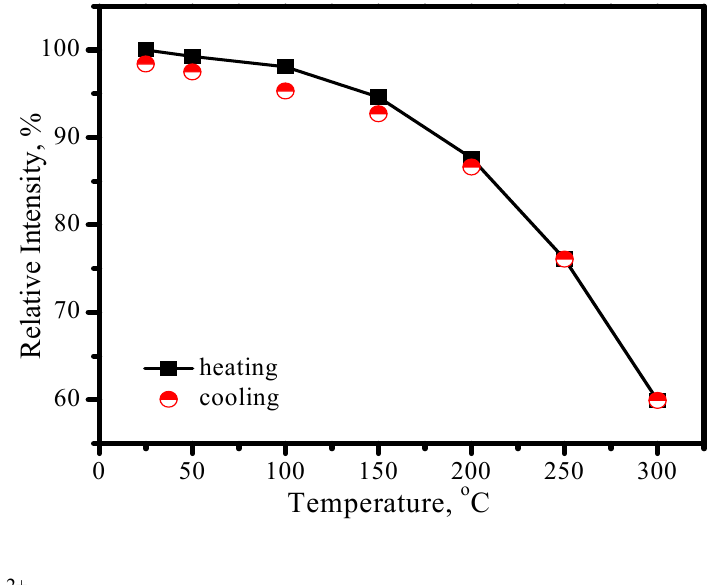
Figure 7. The XRD pattern of (Sr